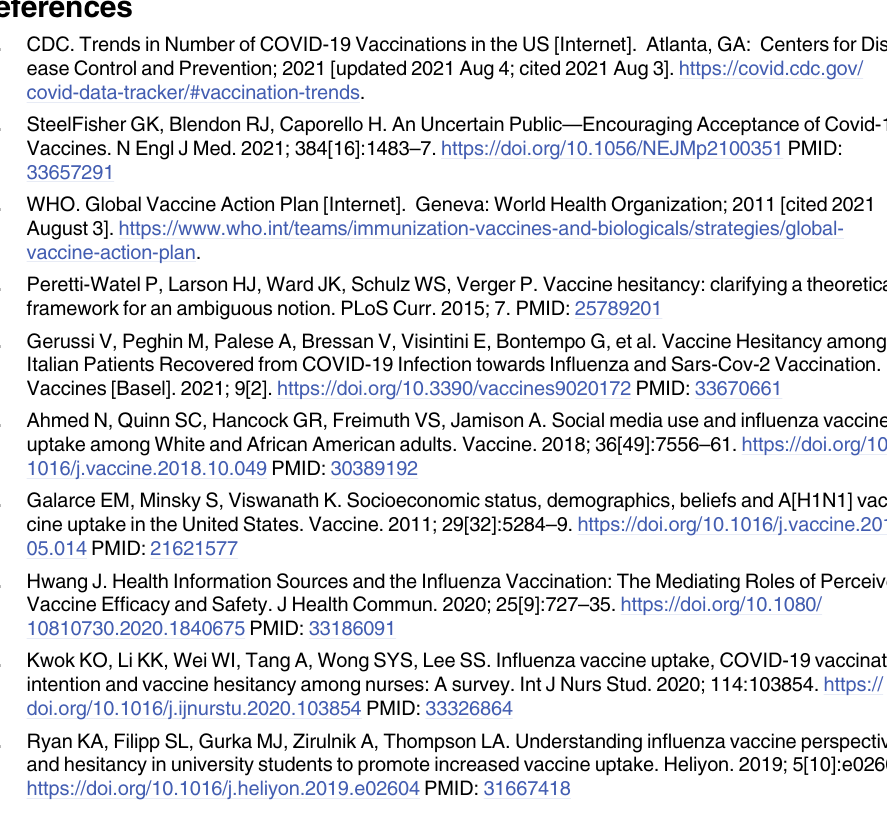
S1 Table. Unadjusted multinomial regression of unvaccinated groups compared to fully/ partially vaccinated group as a reference